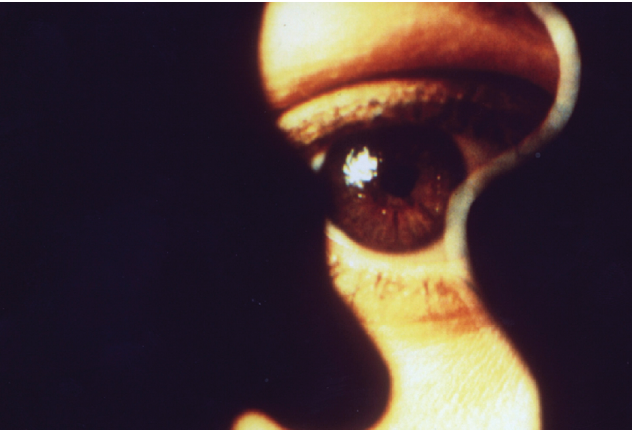
Figure 5 – Still from the audiovisual essay Movement, Framework, Cut (2019), by Nuno Dias.